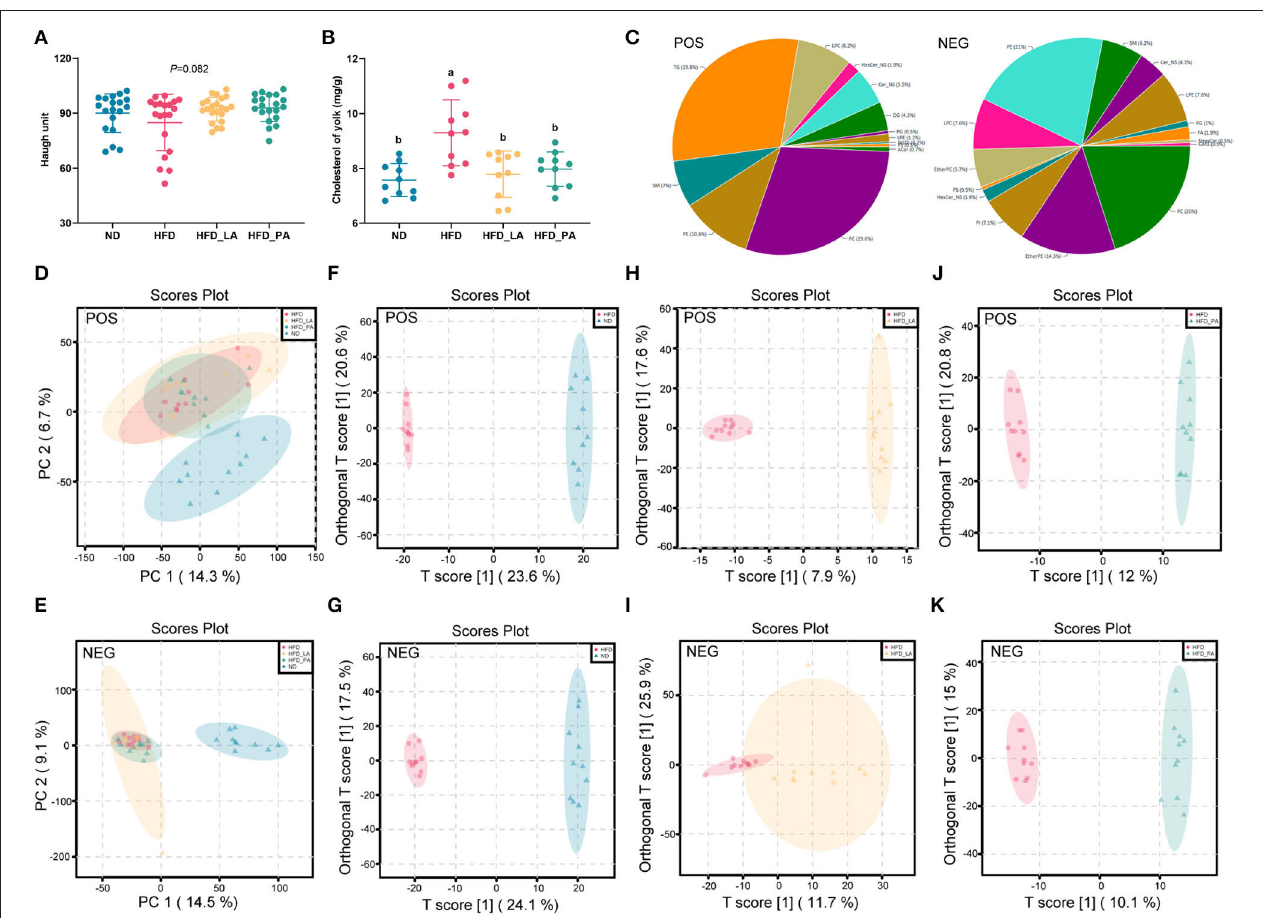
FIGURE 3 | Akkermansia muciniphila improved egg quality and the lipid profile of egg yolks in laying hens with fatty liver hemorrhagic syndrome (FLHS). (A) Haugh unit ( n = 30). (B) Cholesterol content in the yolk (mg/g) ( n = 10). (C) Distribution of lipid classes and species identified in egg yolk samples from the four treatment groups. (D,E) Principal component analysis (PCA) score plots among the four treatment groups in positive ion (ES + ) and negative ion (ES–) modes. (F,G) The orthogonal partial least squares discriminant analysis (OPLS-DA) score plots between the normal diet (ND) and high-fat diet (HFD) groups in ES + and ES– modes. (H,I) The OPLS-DA score plots between the HFD and HFD + live A. muciniphila (HFD_LA) treatment groups in ES + and ES– modes. (J,K) The OPLS-DA score plots between the HFD and HFD + pasteurized A. muciniphila (HFD_PA) treatment groups in ES + and ES– modes. Different letters indicate significant differences at p